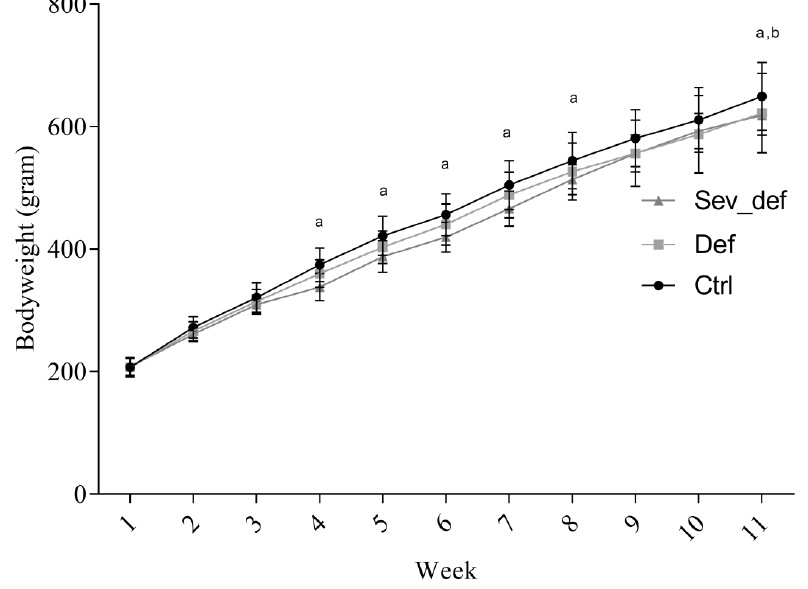
Figure 3. Changes in guinea pig bodyweight during the study. The Sev_def group showed mild growth retardation from week 4, but caught up with Def animals by week 9. At termination, there was a significant difference between Ctrl and Def and Sev_def. a Ctrl vs. Sev_def, p < 0.05; b Ctrl vs. Def, p < 0.05. Two-way repeated-measures ANOVA with Tukey’s multiple comparison correction, n = 19, mean ± SD. Ctrl: Control animals, Def: Vitamin C deficient animals, Sev_def: Severely vitamin C deficient animals.